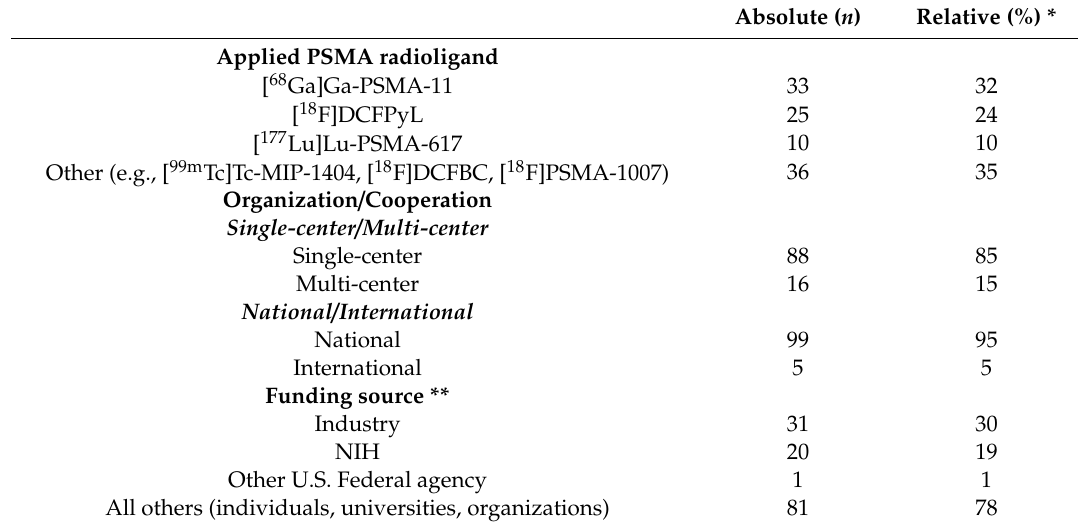
Table 1. Applied radiotracers and organizational parameters of the included prospective clinical prostate cancer-related trials with PSMA-radioligands from the ClinicalTrials.gov registry ( n = 104).